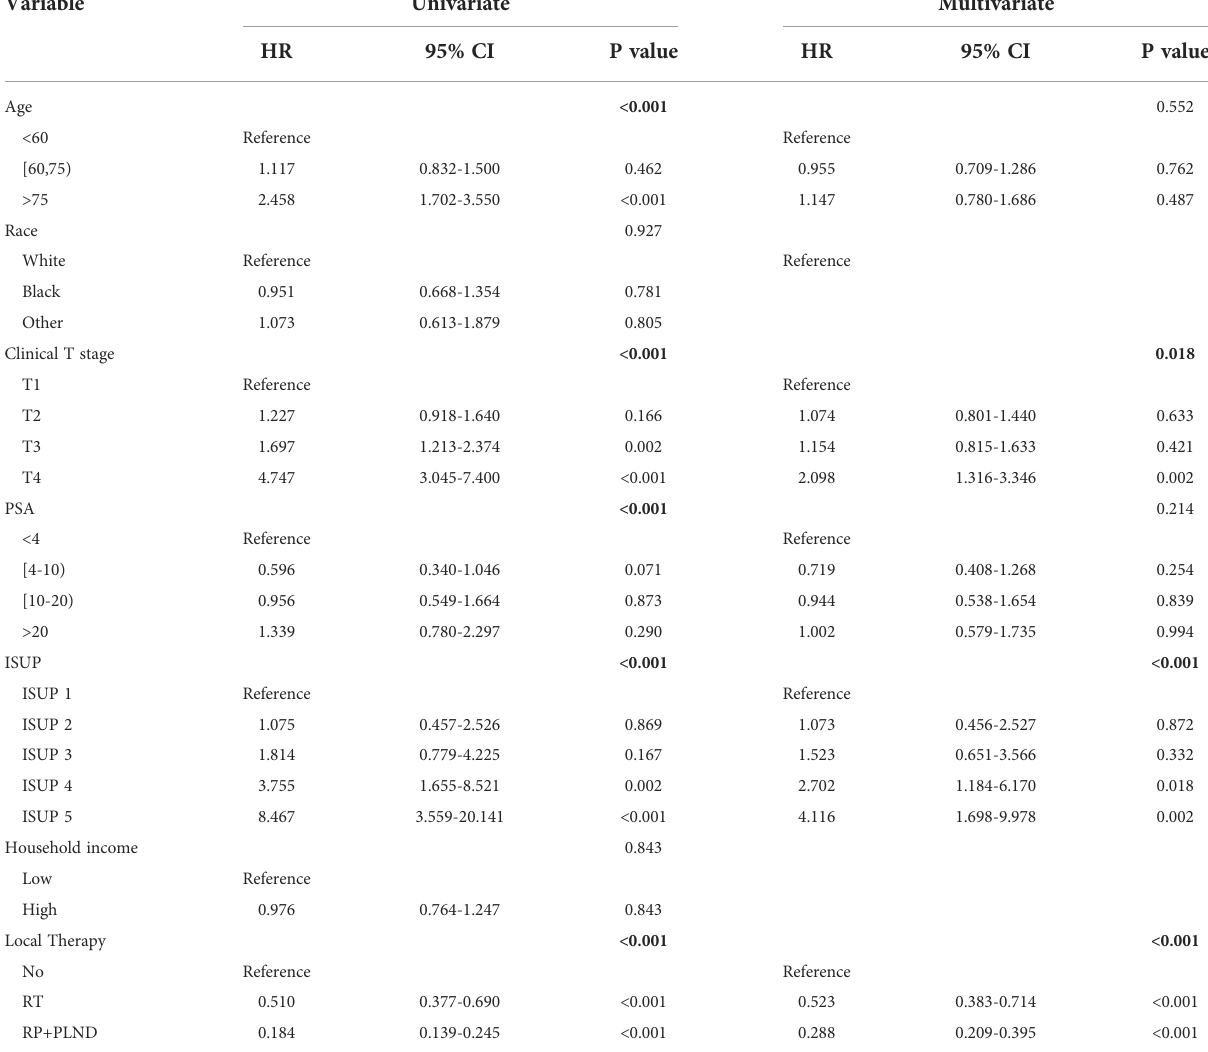
TABLE 1 Uni- and multivariate Cox regression models for predicting OS in cN1M0 prostate cancer